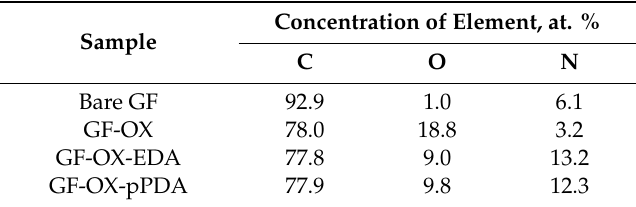
Table 1. Data of Energy Dispersive X-ray (EDX) analysis of bare GF, GF-OX, GF-OX-EDA, and GF-OX-pPDA samples.